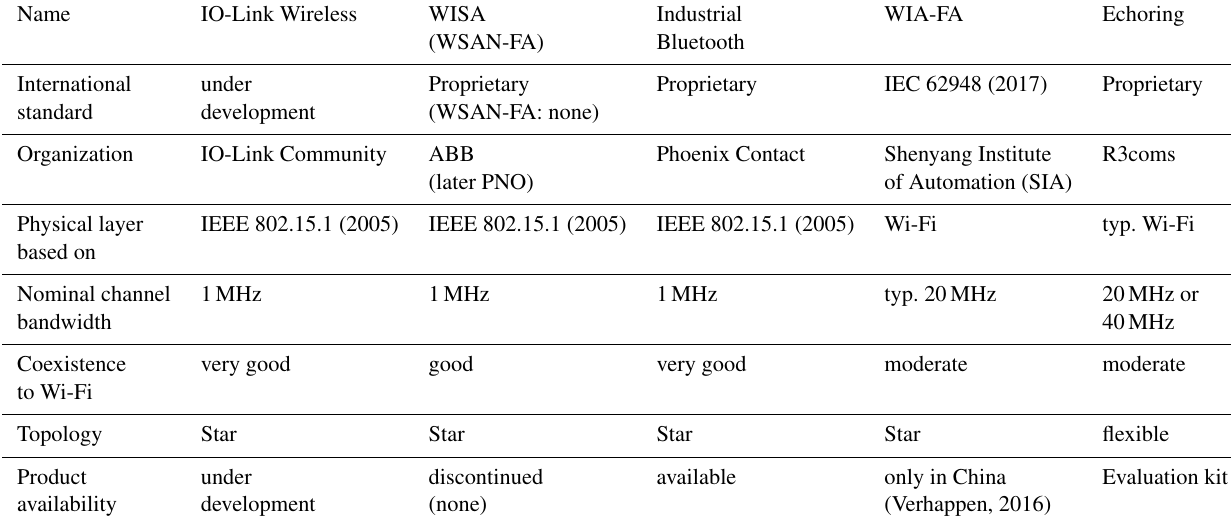
Table 1. Selection of requirements for different wireless standards addressing factory